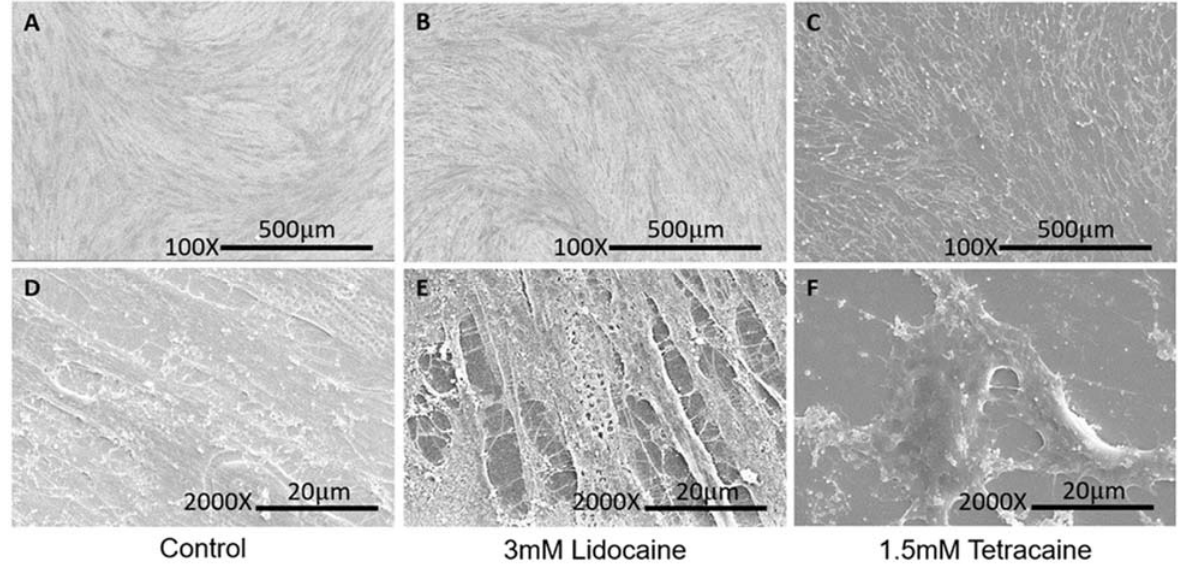
Figure 4. SEM images of CCD-1064sk (human skin fibroblast). ( A – C ) Images of CCD-1064sk magnified 100 times in control, 3 mM lidocaine, 1.5 mM tetracaine, respectively. ( D – F ) Images of CCD-1064sk magnified 2000 times in control, 3 mM lidocaine, 1.5 mM tetracaine, respectively .